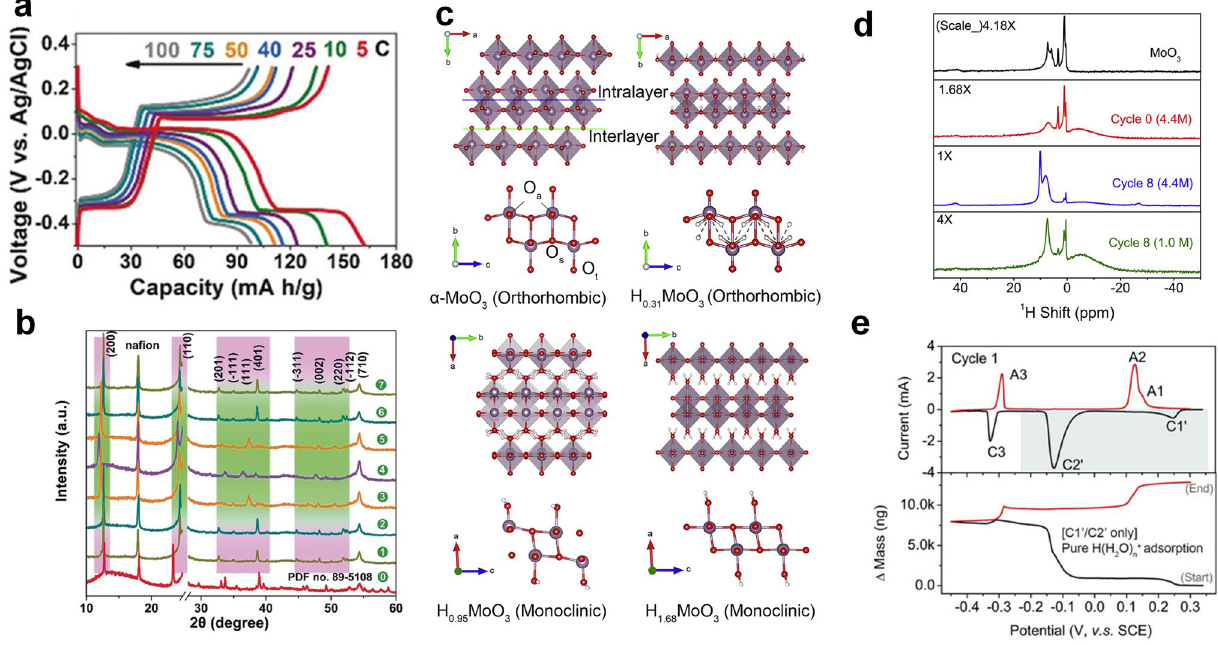
Fig. 7 a Rate performance of MoO 3 in 1 M H 2 SO 4 . b Ex situ XRD pattern of MoO 3 at different potentials [28]. Copyright 2018, Wiley–VCH. c Structural changes of α -MoO 3 during electrochemical reactions. d 1 H Solid-state NMR of original MoO 3 sample and cycled sample. e The CV and EQCM curves of